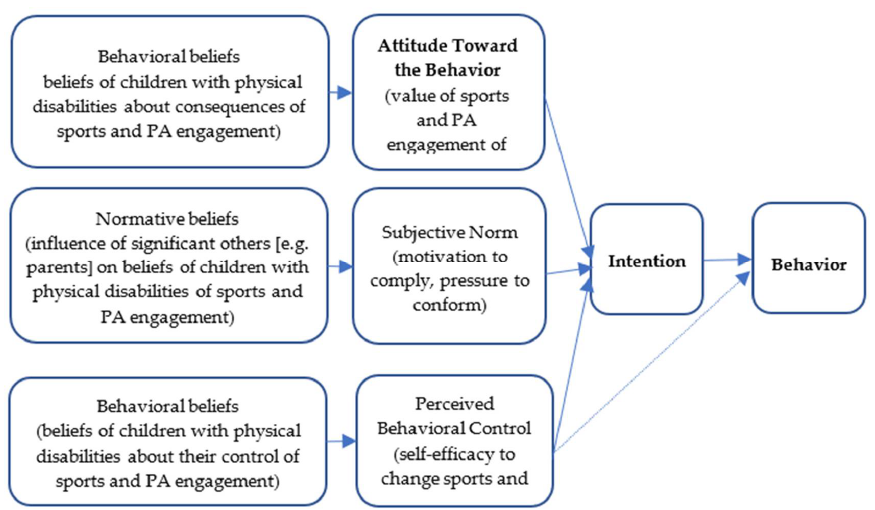
Figure 1. Application of the theory of planned behaviour model in sports and physical activity engagement of children with physical disabilities contexts.